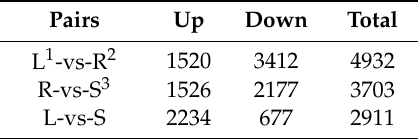
Figure 3. Analysis of di ff erentially expressed genes ( a ) Venn diagrams of di ff erentially expressed genes (DEGs) among three parts of Scutellaria baicalensis . ( b ) Heatmap of key genes involved in flavonoid biosynthesis in S. baicalensis . Note: Each square along the longitudinal axis is the value of log2 fragments per kilobase of transcript per million mapped reads (FPKM) of the corresponding gene. Red corresponds to high expression, and green corresponds to low expression. Table 2. Number of di ff erentially expressed genes.